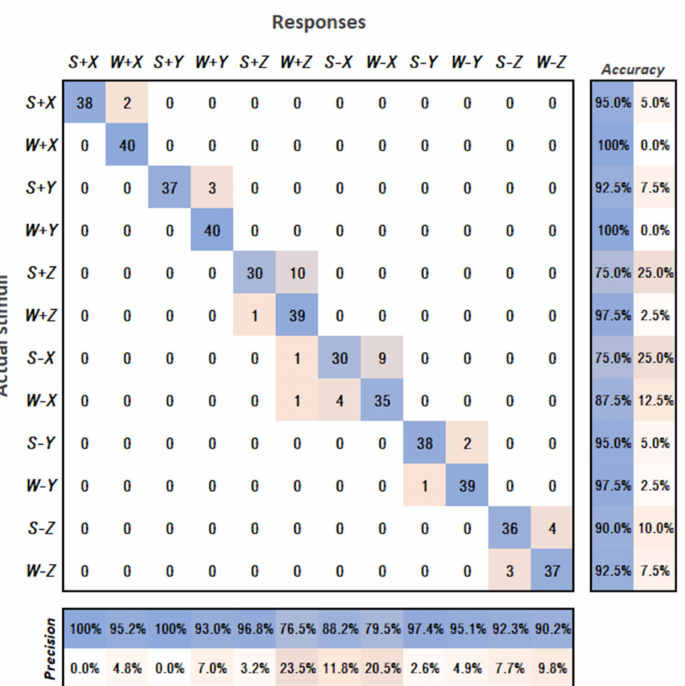
Figure 13. Confusion matrix of all combinations of stimulation intensities (S—strong; W—weak) and directions (+X, − X, +Y, etc.) for all participants. The actual stimuli (ground truth) applied to the participants are pictured along the vertical axis. The participants’ responses are listed along the horizontal axis. Darker values indicate combinations reported with higher frequency. Precision and accuracy values are indicated below and to the right of the confusion matrix,